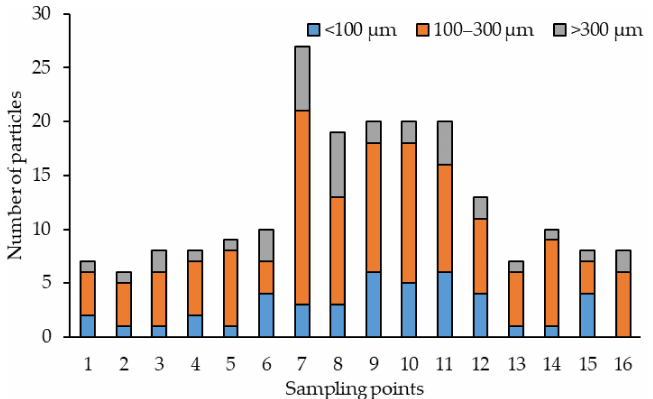
Figure 4. The total number of different sized particles depending on the sampling point.